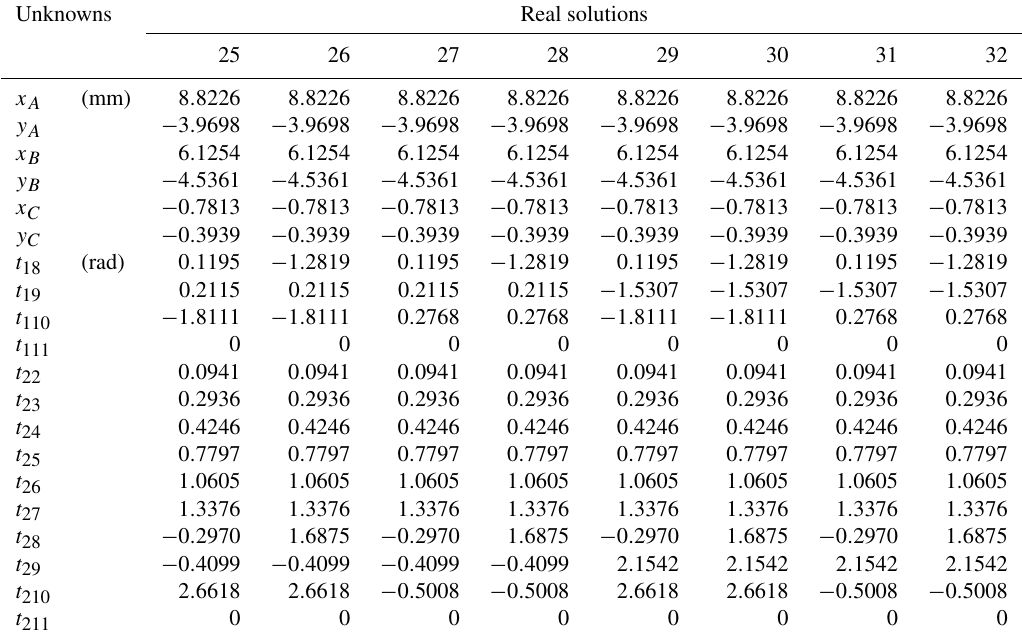
Table A9. Real solutions